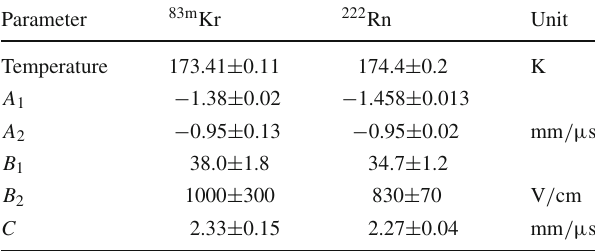
Fig. 21 Dependence of the drift velocity on the temperature for a few selected values of the drift field Table 2 Summary of fit parameters to Eq. 3 for 83m Kr and 222 Rn mea- surements at given